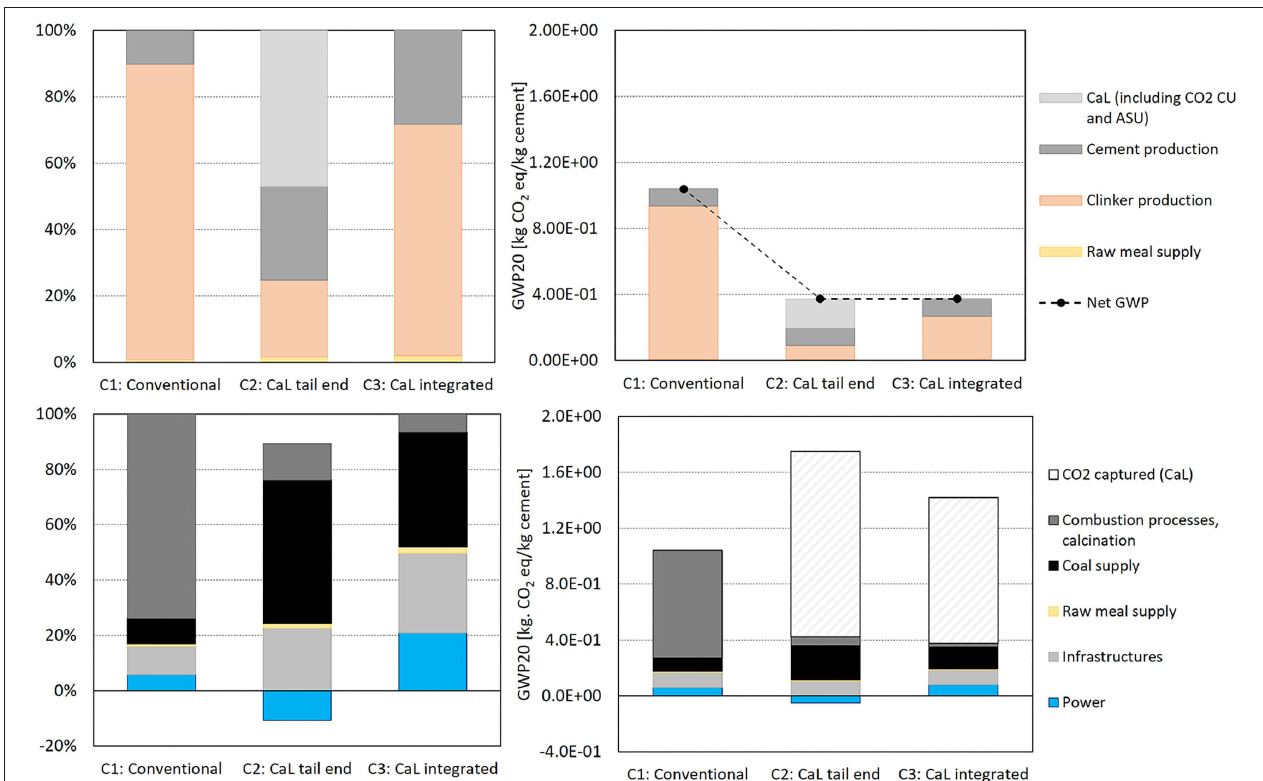
FIGURE 6 | GWP20 contribution analysis and relative emissions of the systems analyzed per kg of cement produced by the different phases (upper panels) and type of processes (lower panels) of the entire cement production